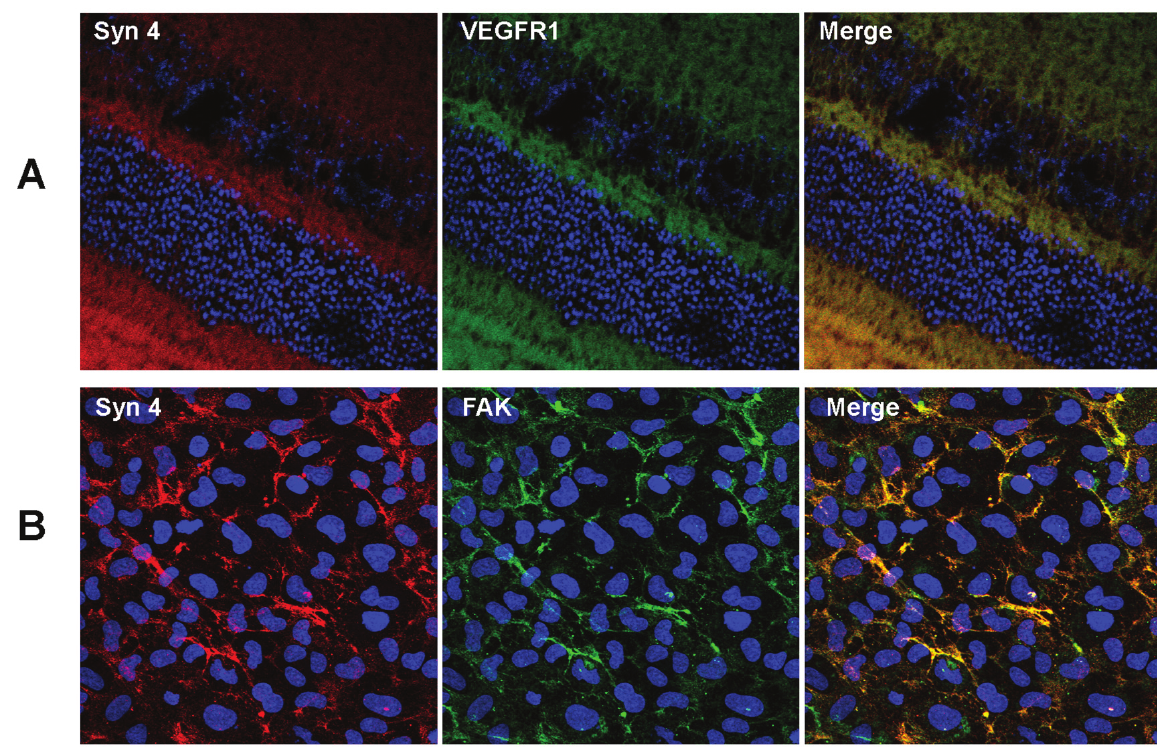
Fig. 4 – Confocal immunofluorescence microscopy showing syndecan-4 cellular localization and protein interactions. (A) Rat retina tissue was triple stained using a monoclonal anti-syndecan-4 (red), anti-VEGF receptor 1 (green) and DAPI for nucleus (blue). Merge represents the co-localization of syndecan-4 and VEGFR1. (B) Cultured rabbit aorta endothelial cells were triple stained using anti-syndecan-4 (red), anti-Focal Adhesion Kinase (green) and DAPI for nucleus (blue). Confocal imaging shows co-localization of syndecan-4 and FAK. Both figures depict syndecan-4 as a